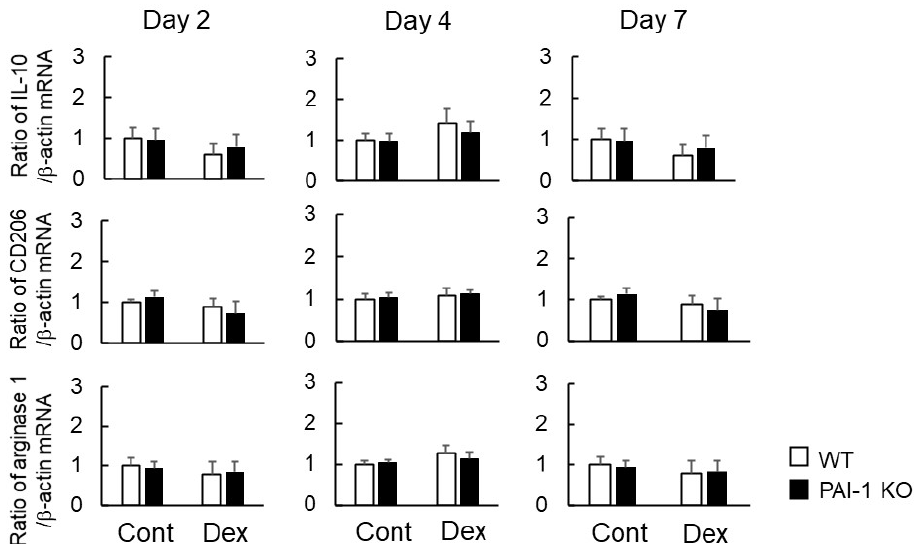
Figure 5. Effects of Dex and PAI-1 deficiency on the expression of M2 macrophage-producing factors at damaged sites after femoral bone injury. A real-time PCR analysis of the mRNA levels of IL-10 , CD206 , arginase 1 , and β -actin at damaged sites 2, 4, and 7 days after femoral bone injury in WT and PAI-1 KO mice. Data are expressed relative to β -actin mRNA values. Data represent the mean ± SEM: n = 5.